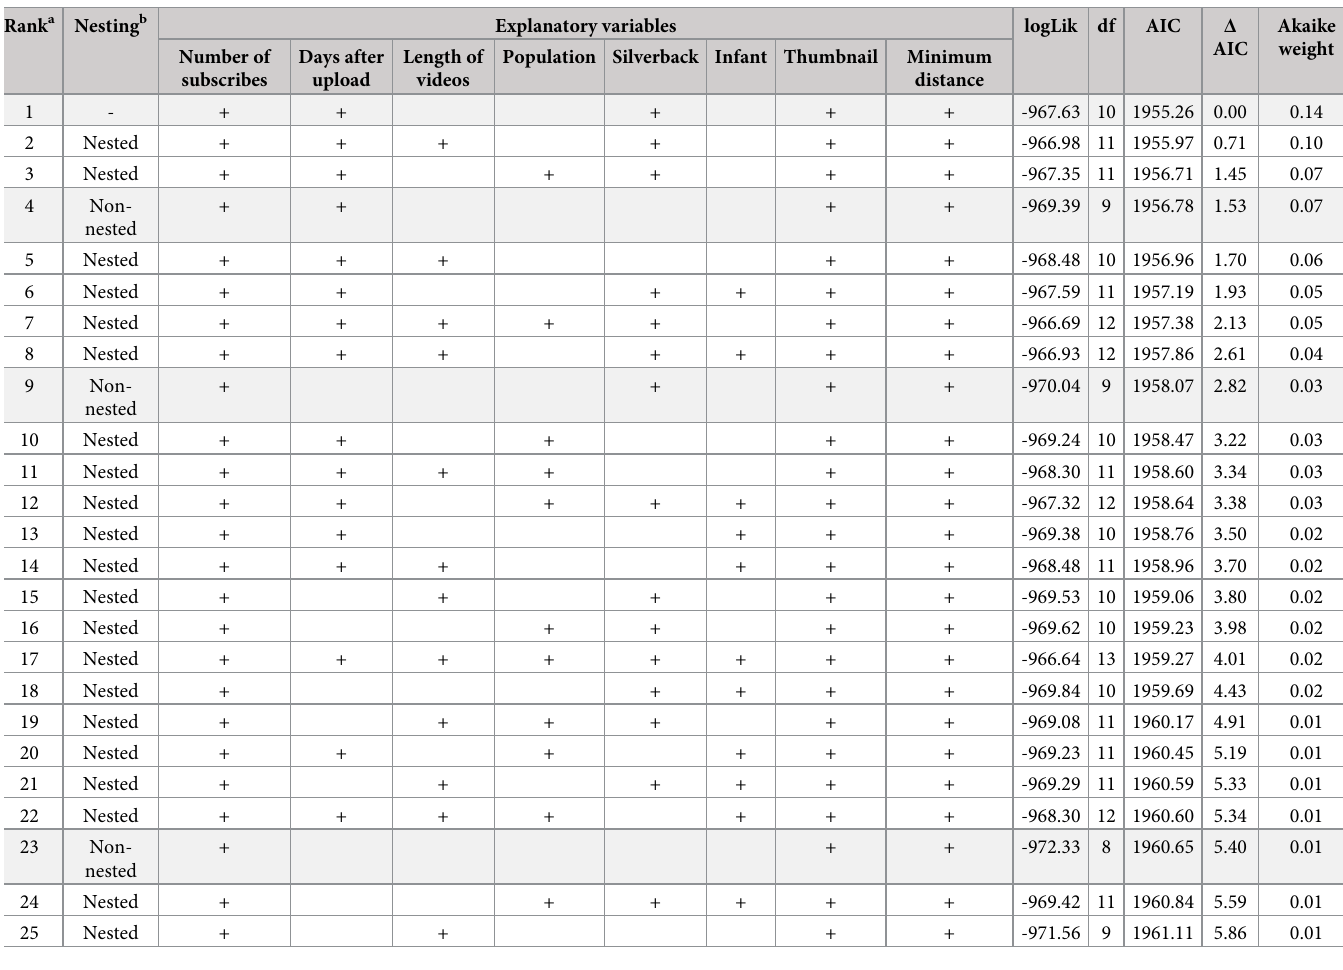
Table 3. Top-ranked candidate models exploring the factors that affect the number of likes of YouTube videos related to mountain gorilla tourism (only the models with Δ AIC values less than 6 are shown). (N = 206). Rank a Nesting